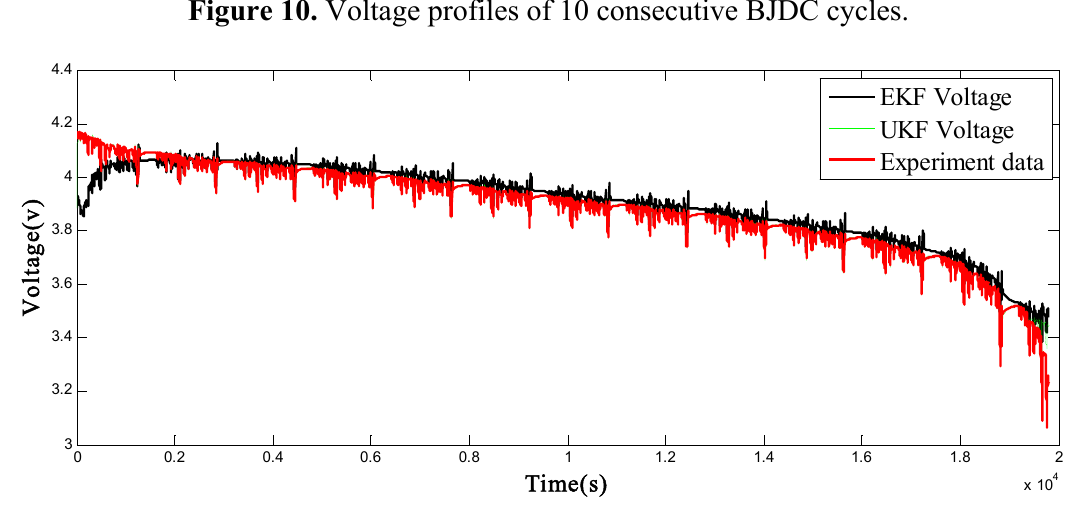
Figure 11. Terminal voltages and voltage error comparisons between UKF and EKF.